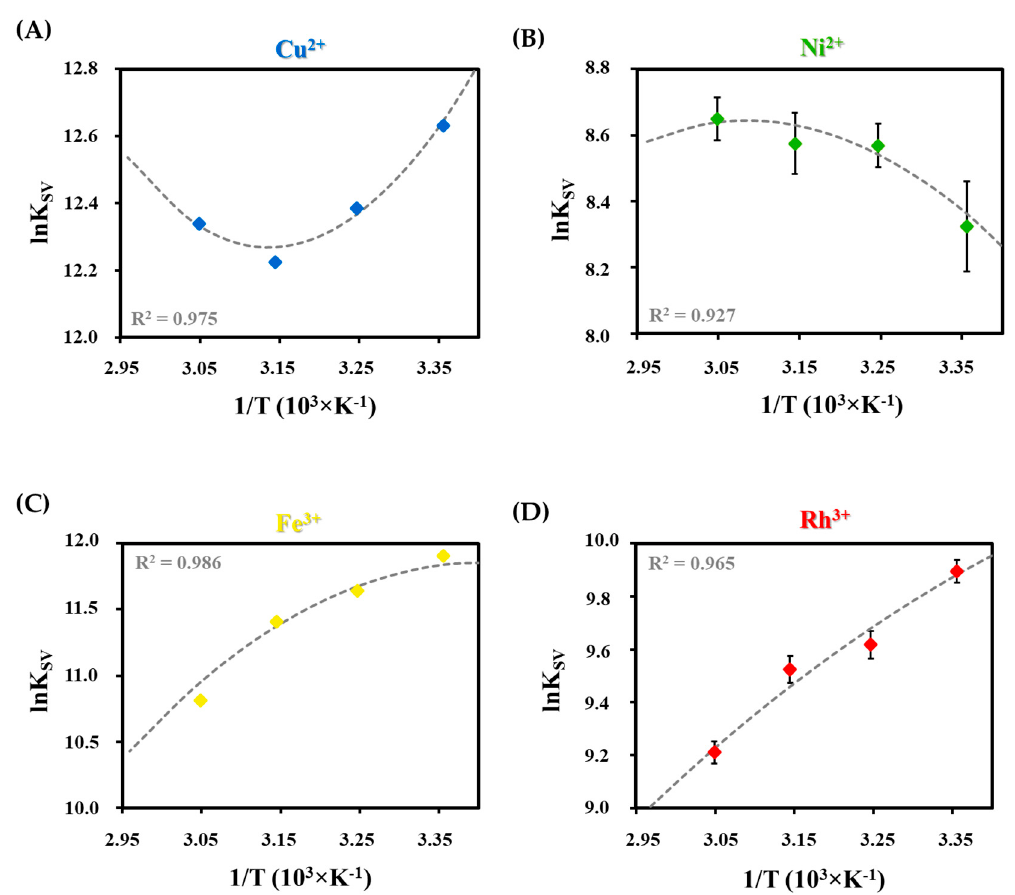
Figure 6. Nonlinear van’t Hoff fitting with the correlation coefficients (R 2 ) in the case of ( A ) Cu 2+ , ( B ) Ni 2+ , ( C ) Fe 3+ , and ( D ) Rh 3+ ion and Tyr-Ag NC interactions. Interaction between Tyr-AgNCs and divalent ions (Cu 2+ and Ni 2+ ):